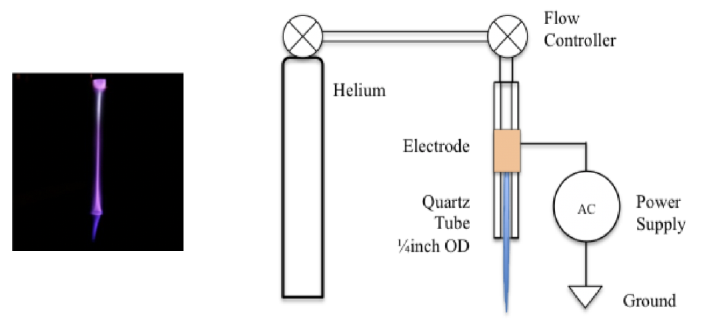
Figure 1. The plasma discharge was generated using a gas flow through a 6.35 mm outer diameter quartz tube with a single electrode powered by an alternating current power supply. The power supply used had a frequency of 18 kHz and a 17 kV peak to peak voltage. Helium was flowed through the tube at a rate of 50 sccm. The tadpoles were exposed indirectly to the glow region of the discharge, but approximately 3 cm beneath the tube. Inside the tube, optical emission spectroscopy confirmed that the emissions were produced by OH radicals and molecular